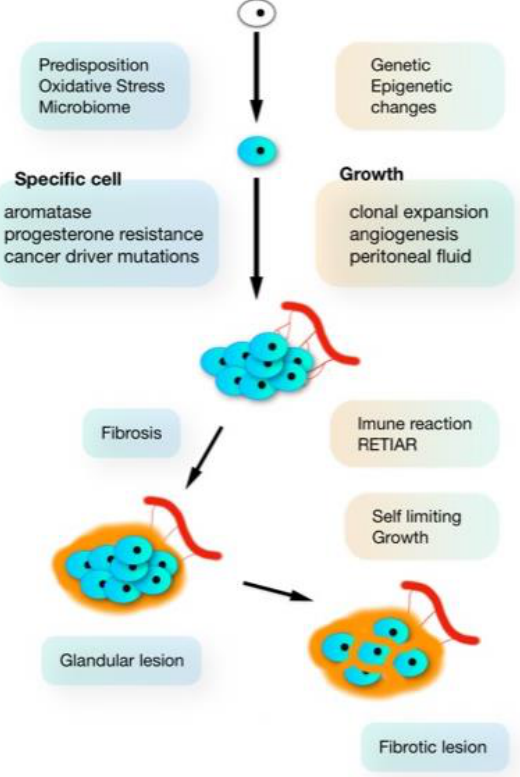
Figure 2. Origin and development of endometriosis: a combination of G-E events, with further growth, immune response, inflammation and fibrosis (figure from [7]).